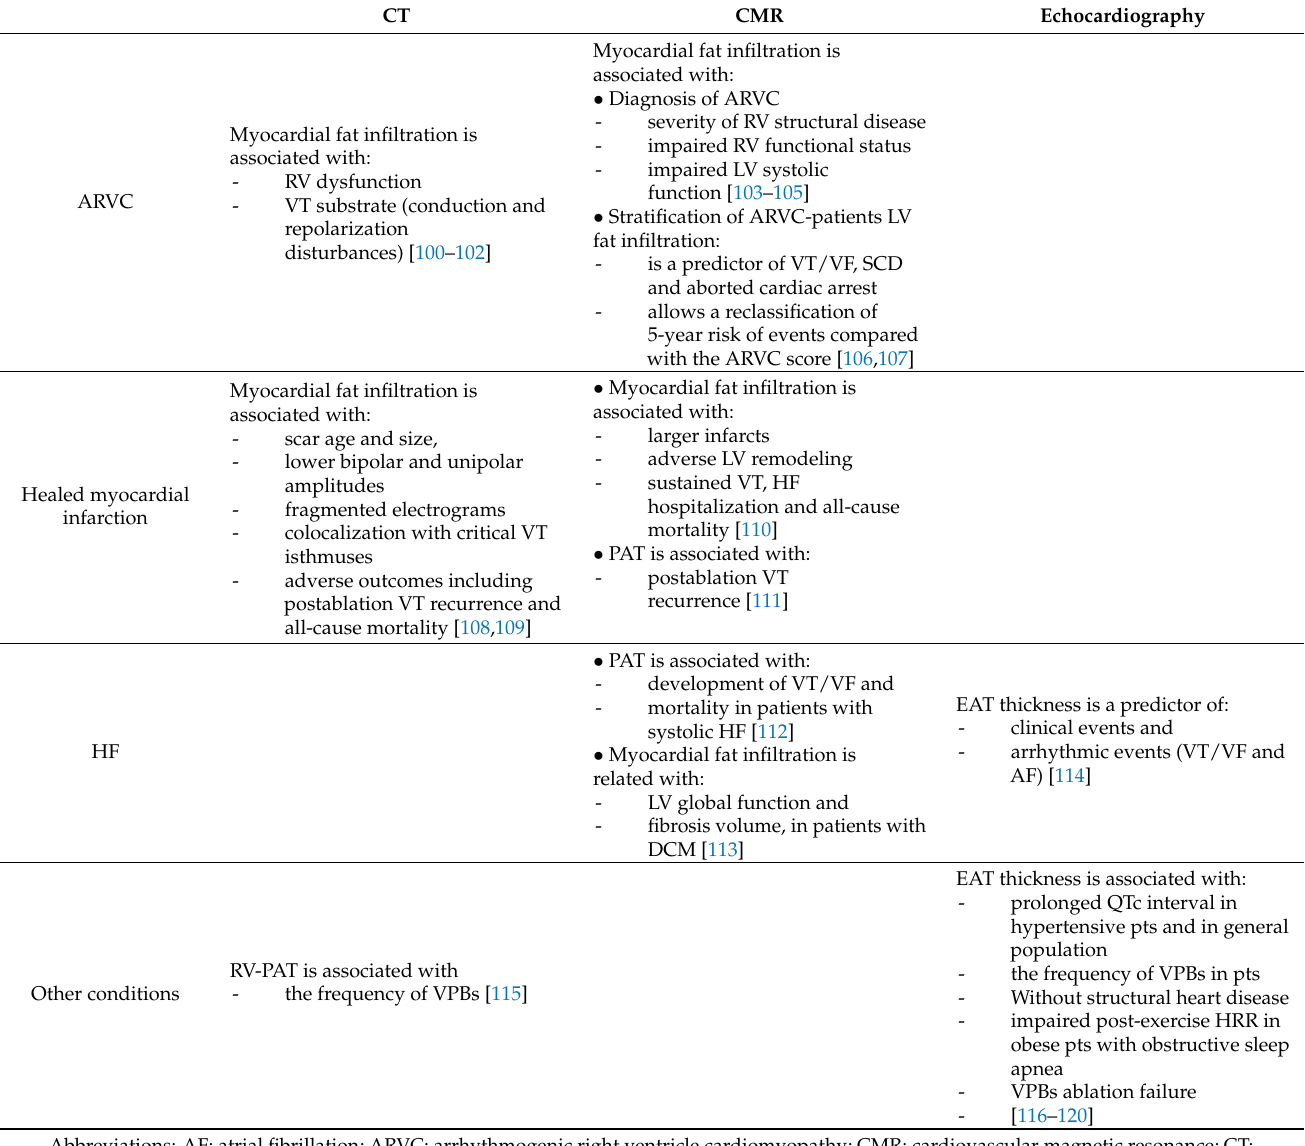
Table 3. Relationship between imaging measures of Cardiac Adiposity and Ventricular Arrhythmias. CT CMR